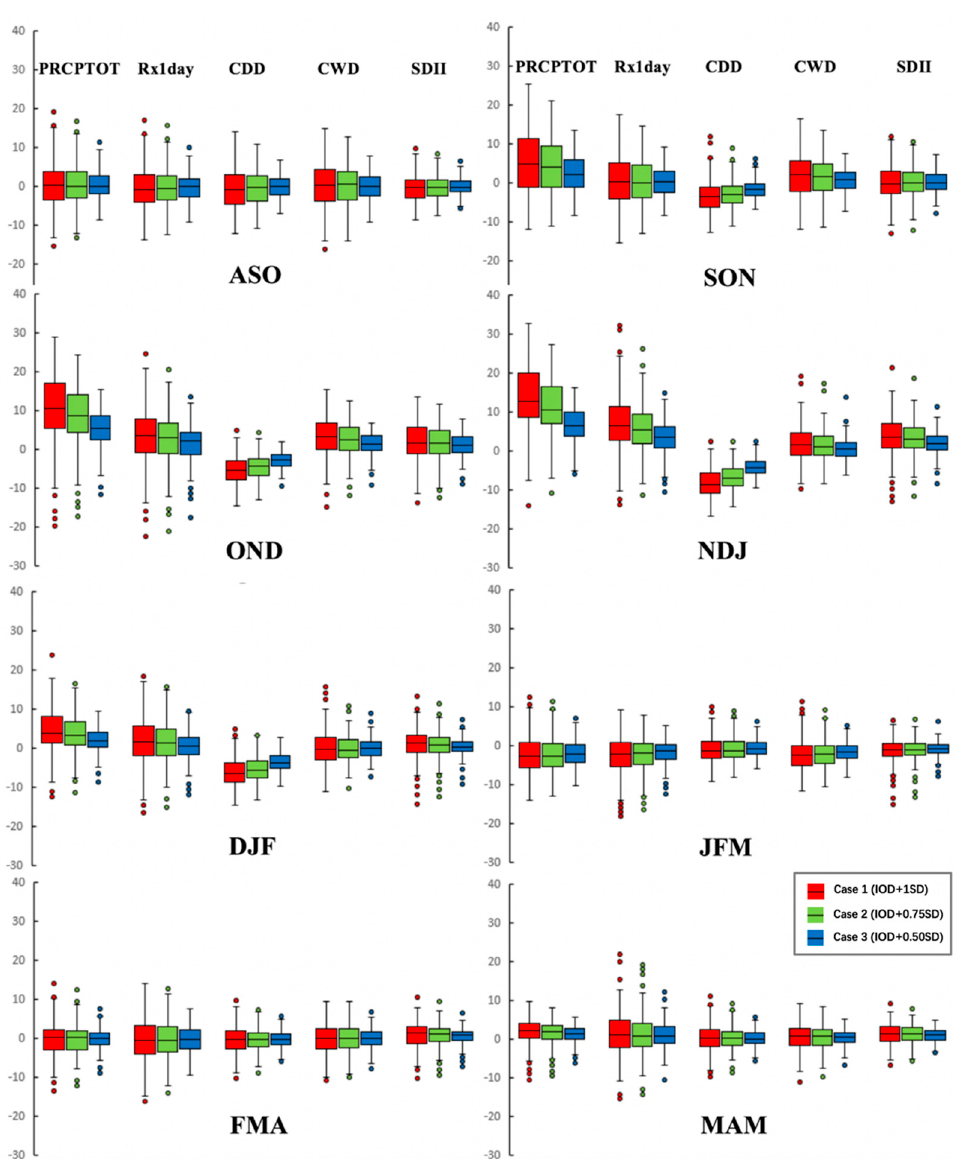
Figure 6. Boxplots of percentage changes in intentionally biased bootstrapping simulation of running three-month precipitation from ASO to MAM (refer to Section 2.2 for definitions) over southern China in the case of five indices (PRCPTOT, seasonal total precipitation on wet days ( ≥ 1.0 mm); Rx1day, maximum 1-day precipitation; CDD, maximum number of consecutive dry days ( < 1.0 mm); CWD, maximum number of consecutive wet days; and SDII, simple daily precipitation index) with different threshold (DMI + 1 SD, DMI + 0.75 SD, and DMI + 0.5 SD) departures from the long-term average (1961– 2017).